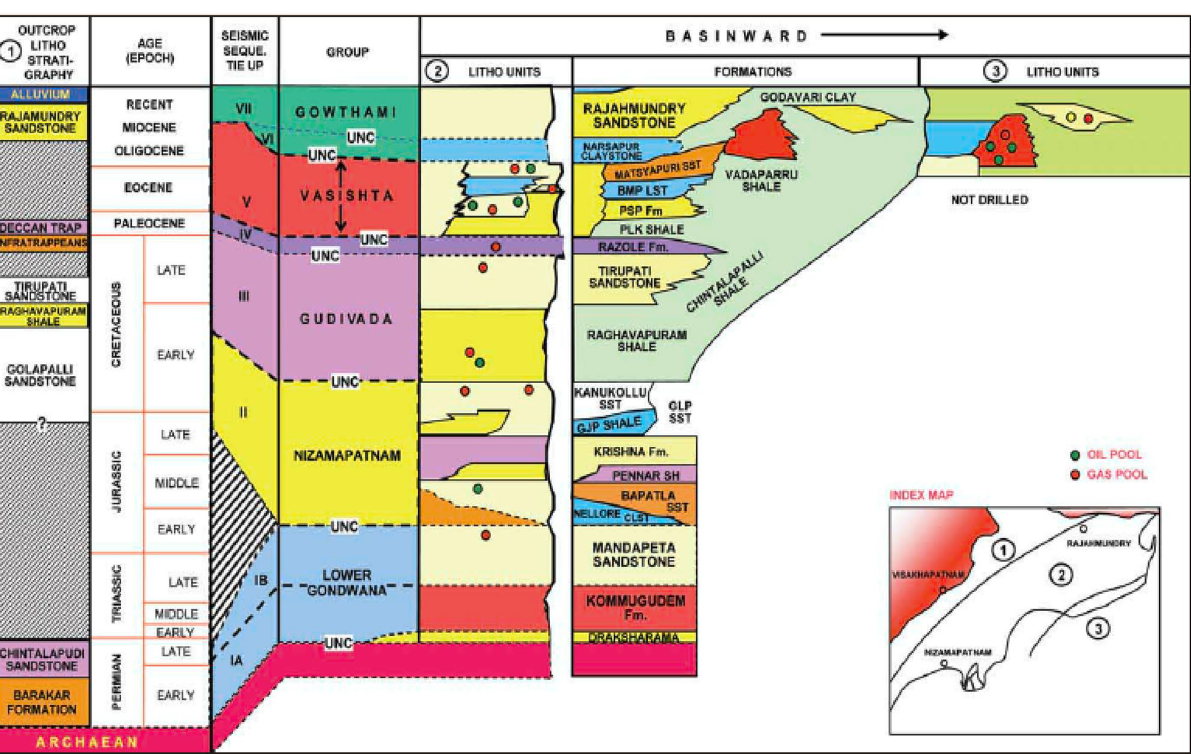
Figure 3. Generalized stratigraphy of KG basin from onshore to offshore 13